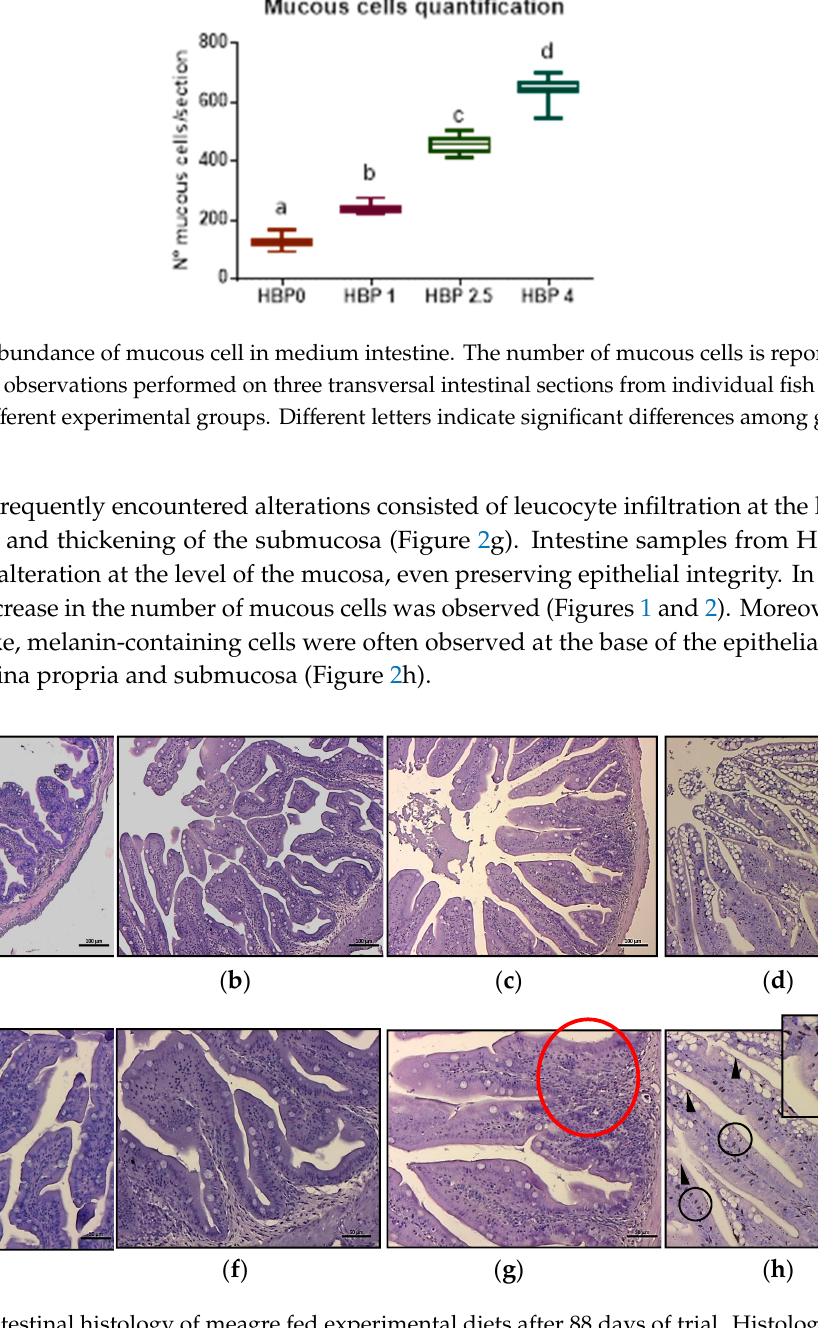
Figure 2. Intestinal histology of meagre fed experimental diets after 88 days of trial. Histology of A. regius medium intestine from the different experimental groups: ( a , e ) normal histology from HBP0 group; ( b , f ) HBP1 group did not show signs of pathological alteration; ( c , g ) in the HBP2.5 group, it was possible to detect inflammatory influx in some portions of the intestinal submucosa (red circle); ( d , h ) the HBP4 group showed a severe degree of mucipar hyperplasia of the mucosa (arrowhead) with an abundant presence of melano macrophages at the base of the enterocytes (black circle and box). Scale bar: a, b, c, d = 200 µ m; e, f, g, h = 50 µ